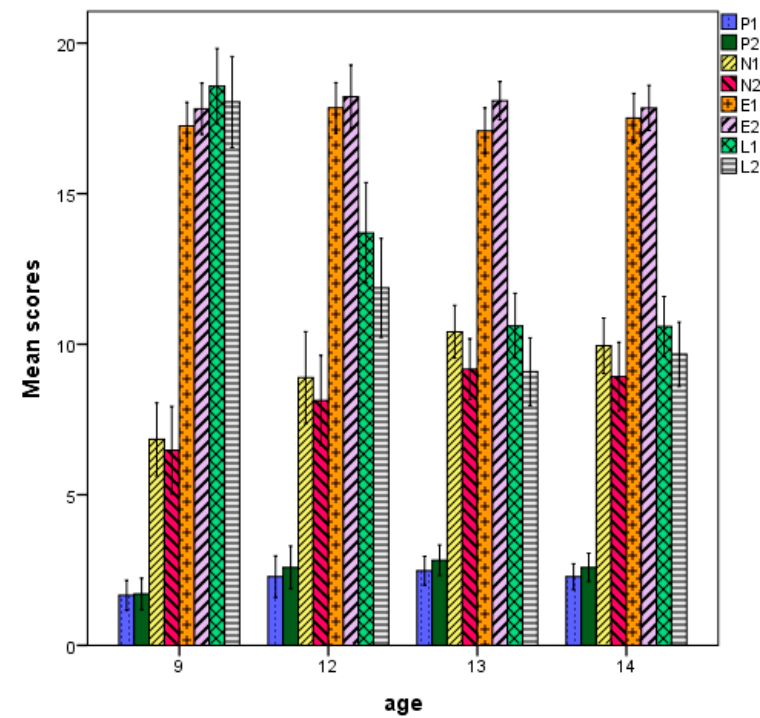
Figure 2. Personality scores across age, testing wave, and personality dimensions.